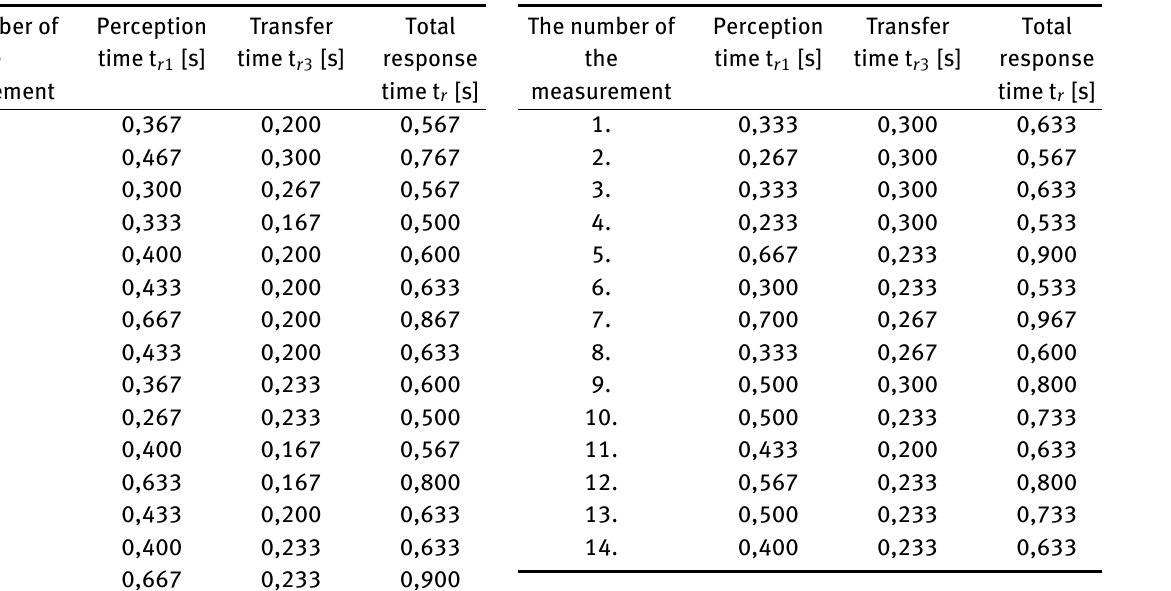
Table 20: Summary of the results of driver